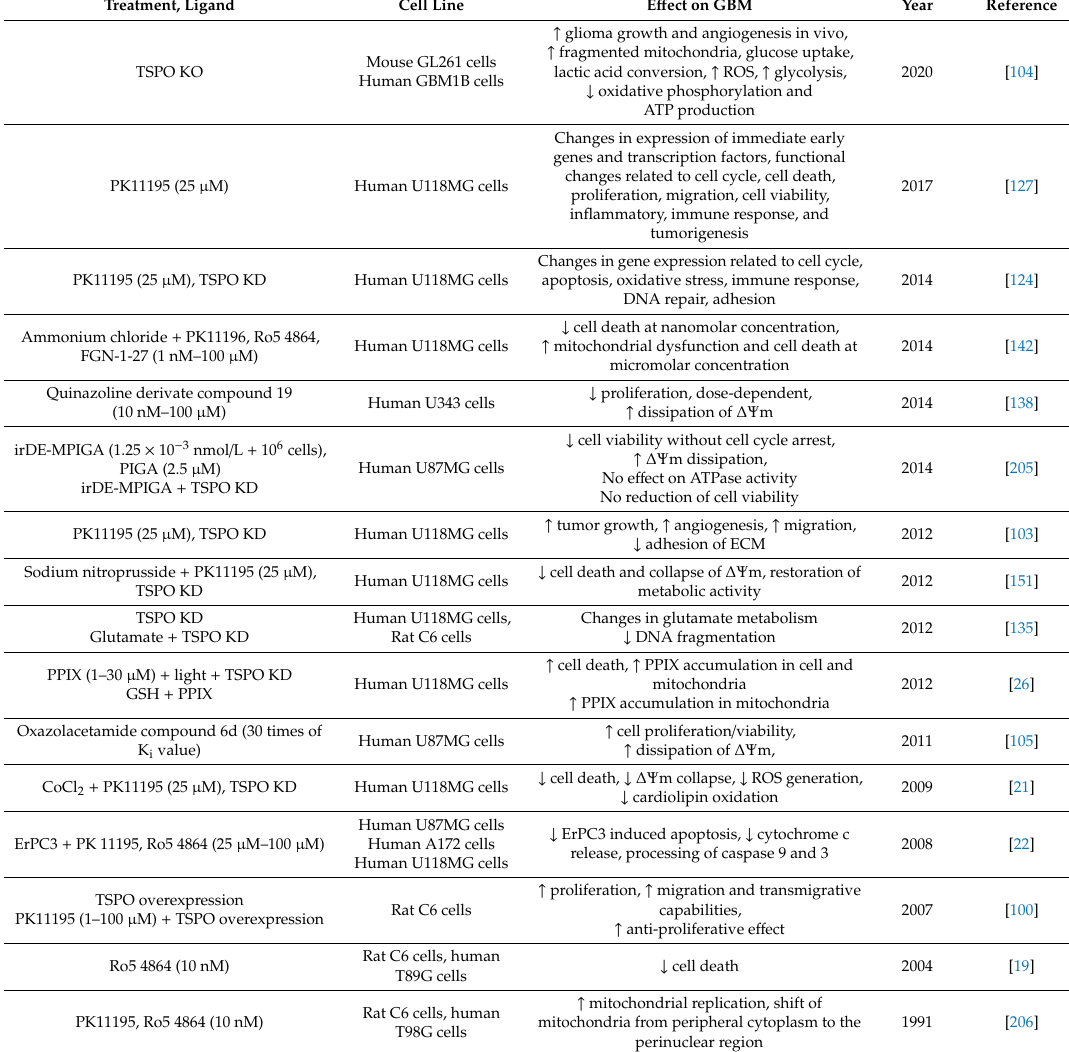
Table 1. Overview of experimental data listing the effects of TSPO modification on different glioma cell lines. Treatment,